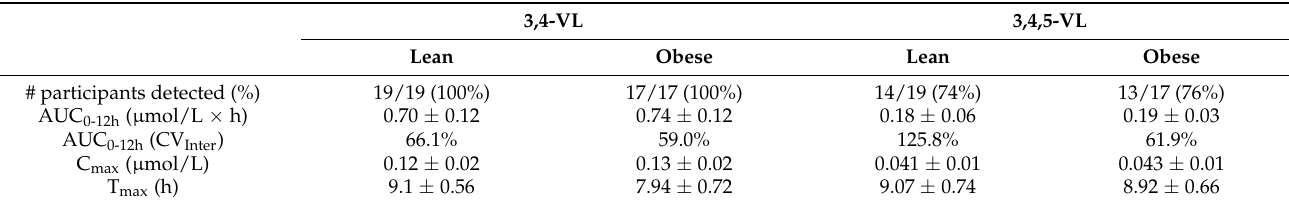
Table 3. Pharmacokinetic parameters of plasma γ -VLs.